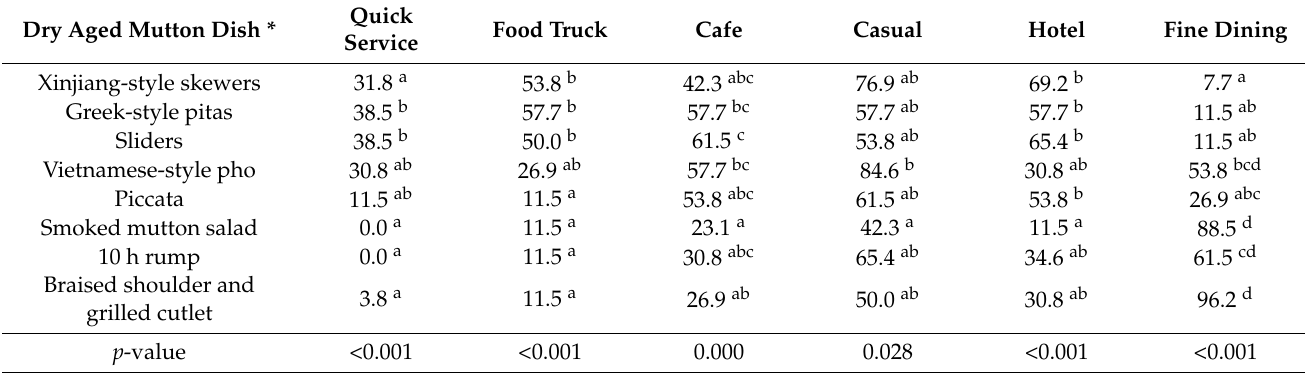
Table 7. Percentage frequency (%) of consumer foodservice outlet selection for dry aged mutton dishes (using check all that apply) and level of significance ( p -value; Cochran’s Q test for each